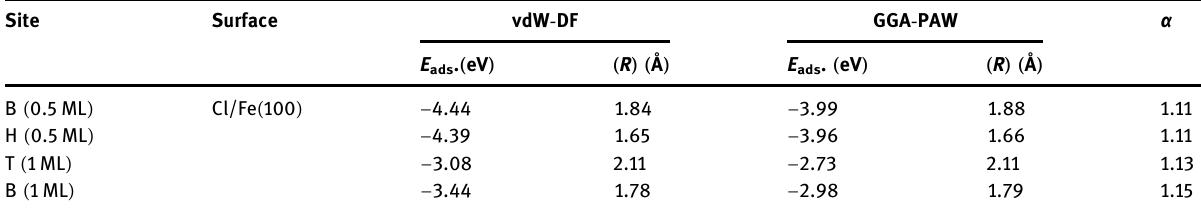
Table 4: Values of E ads. and distance ( R ) using vdW - DF and GGA - PAW functional for chlorine atom adsorbates on the Fe ( 100 ) surface Site